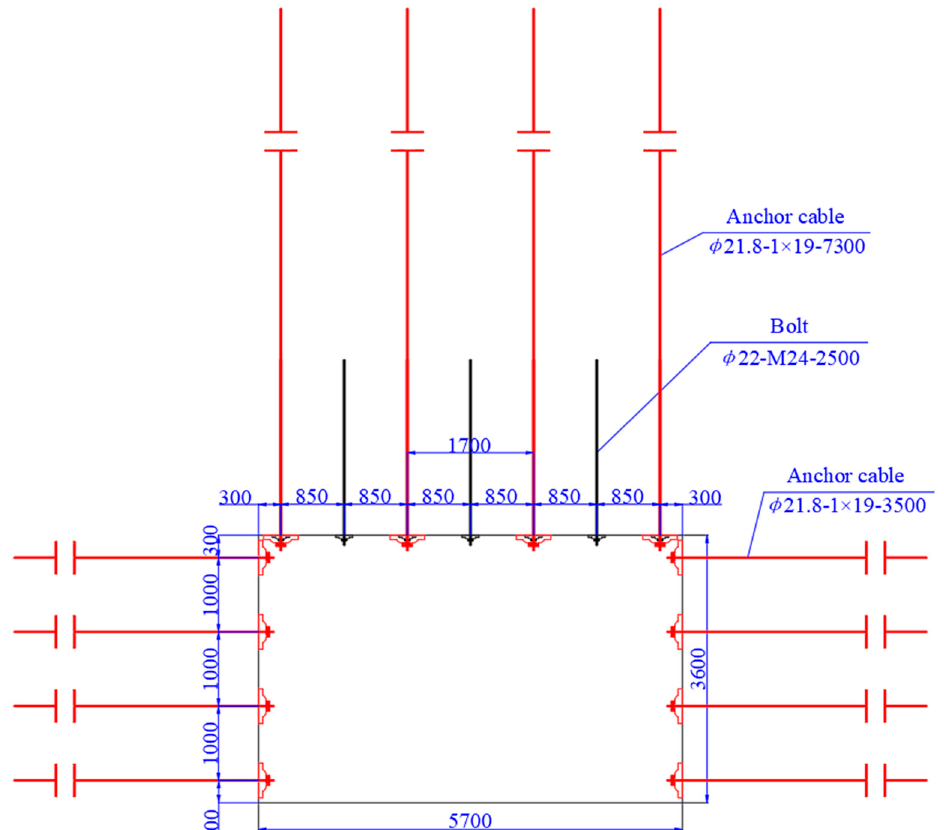
Figure 11. Section support scheme.